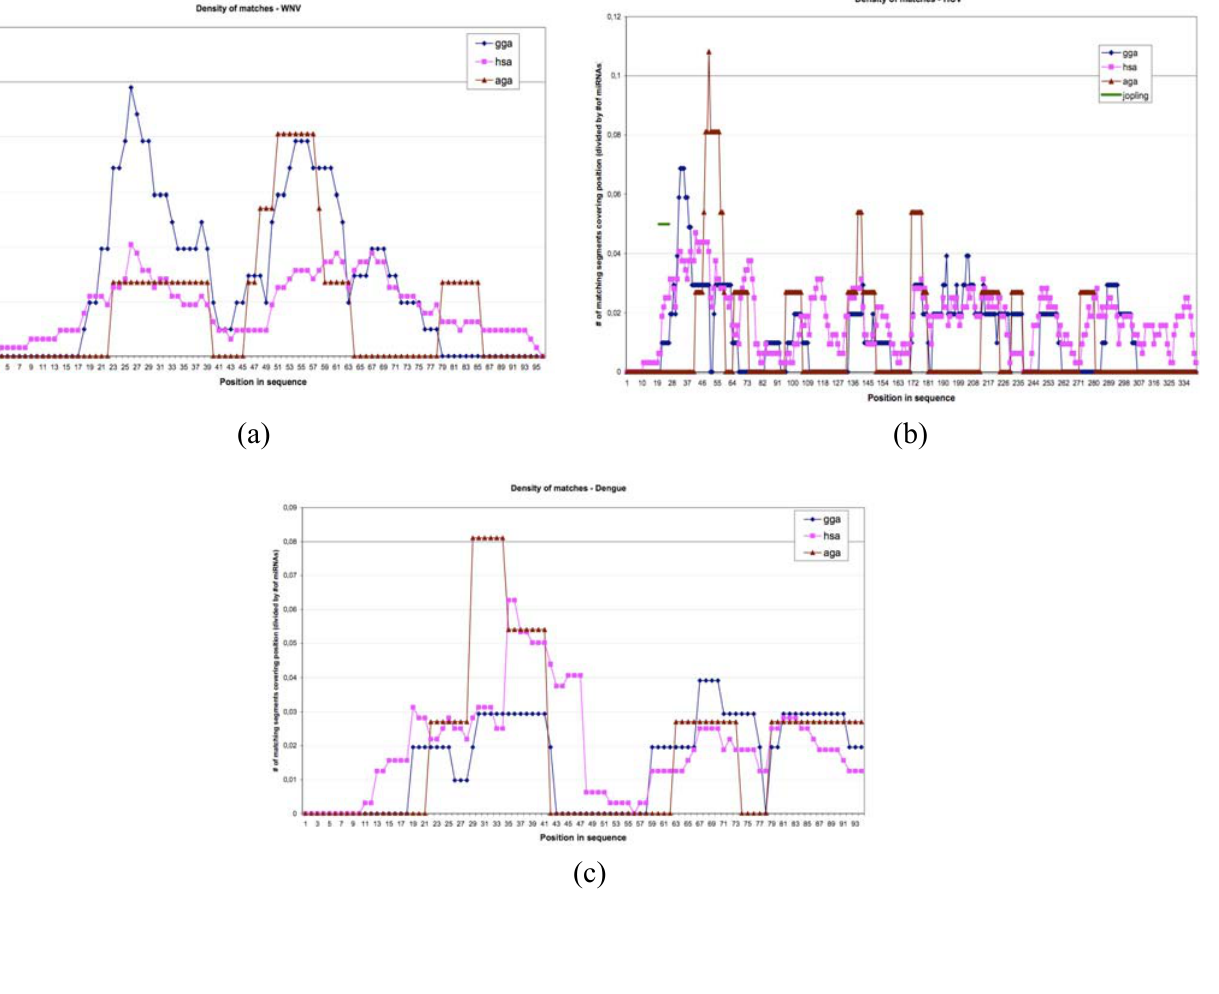
Figure 7. Matching curves between UTR viral (West Nile virus, hepacivirus and dengue), host ( Gallus gallus and human) and vectors ( Aedes and Anopheles )